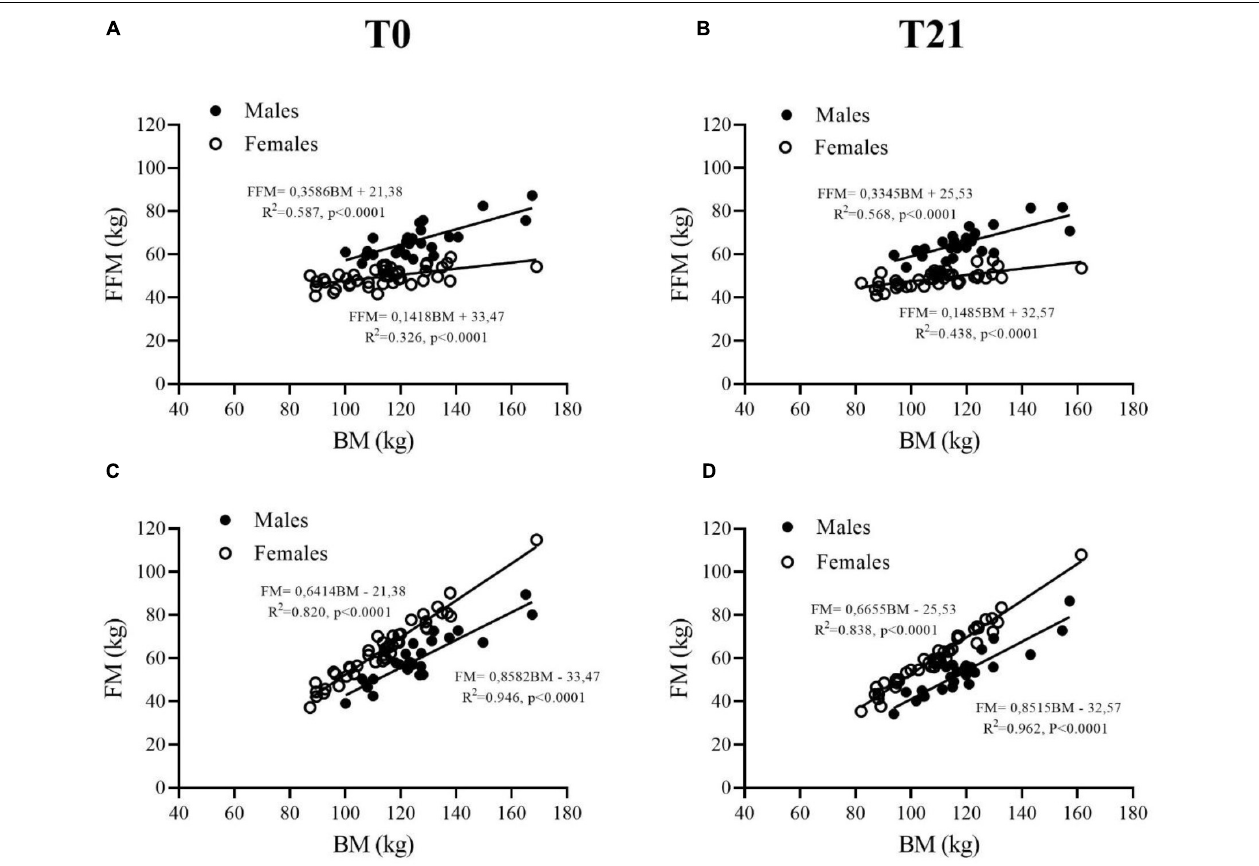
FIGURE 2 | Fat free mass (FFM) (A,B) and fat mass (FM) (C,D) are plotted as a function of body mass (BM) in adult obese males (closed symbols) and females (open symbols) before (T0) and after (T21) of the 3-week BWRP.